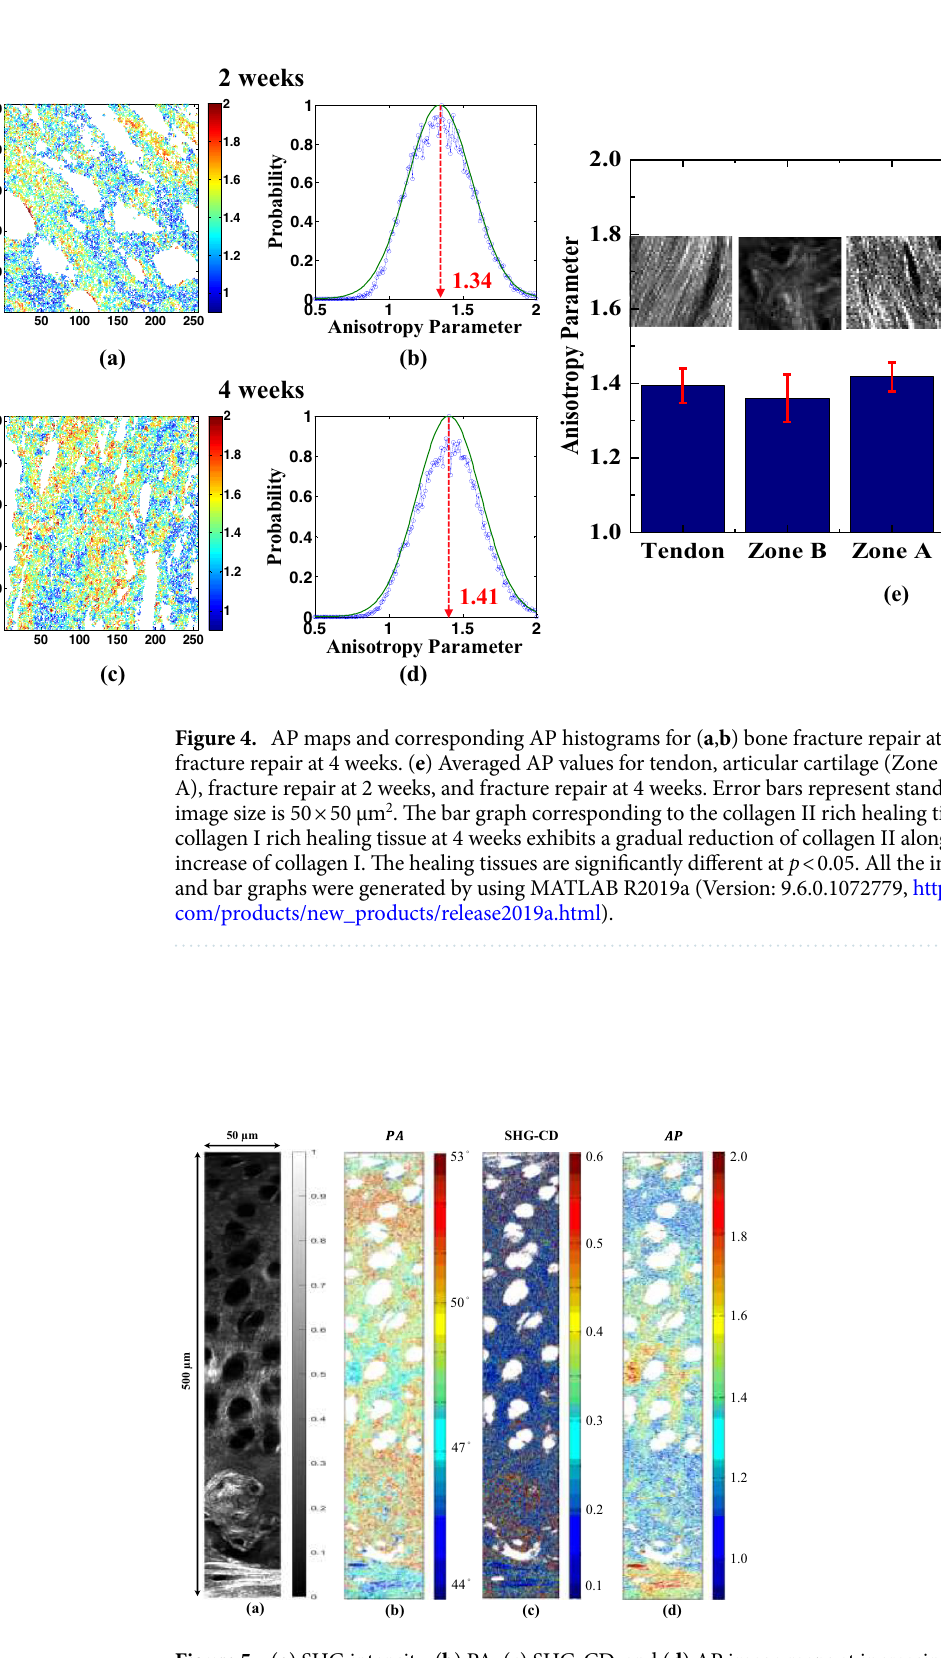
Figure 5. ( a ) SHG intensity, ( b ) PA, (c) SHG-CD, and ( d ) AP image maps at increasing depth of articular cartilage. Size of individual stitched images is 50 × 50 μm 2 . Overall depth imaged is 500 µm. All the image maps were generated by using MATLAB R2019a (Version: 9.6.0.1072779, https:// www. mathw orks. com/ produ cts/ new_ produ cts/ relea se201 9a.